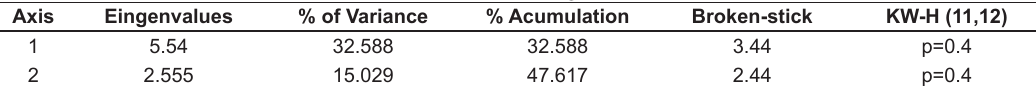
Table 1. Eigenvalues of the Principal Component Analysis by the Broken-stick criterion, percentage of explanation of the axes, and Kruskal-Wallis analysis of variance (KW). P: significance. Axis Eingenvalues % of Variance % Acumulation